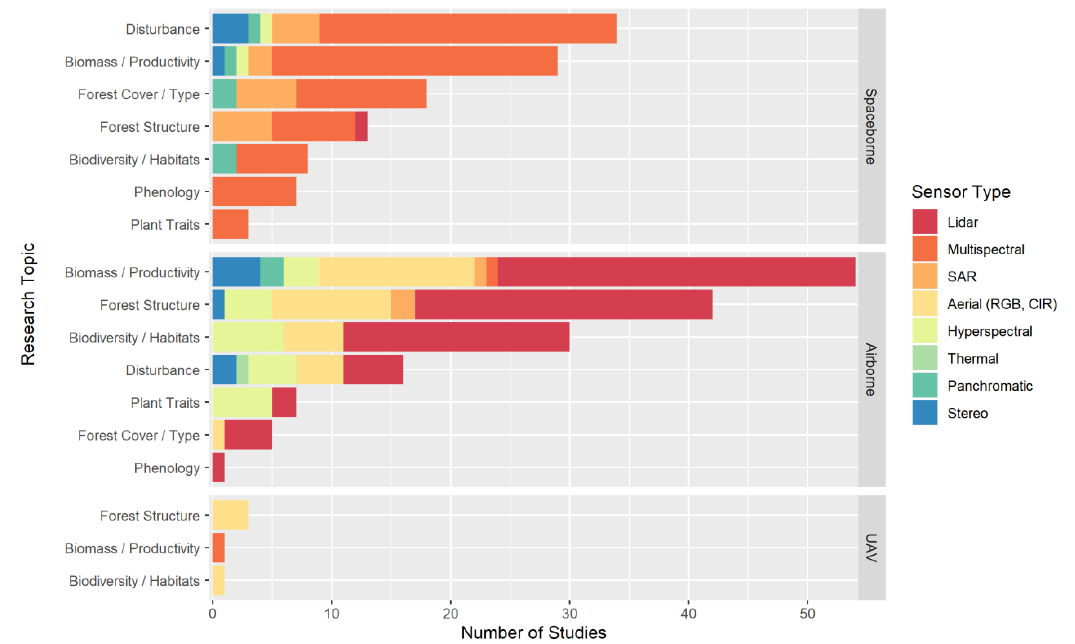
Figure 12. Spatial resolution in relation to platform type and size of study area by object scale investigated. Note that, for improved interpretability of the graphic, a jitter effect has been applied to separate overlapping points from each other, i.e., x-coordinates and y-coordinates are only approximate. Note that studies could be displayed multiple times, if they investigated multiple object scales or utilized multiple sensors.